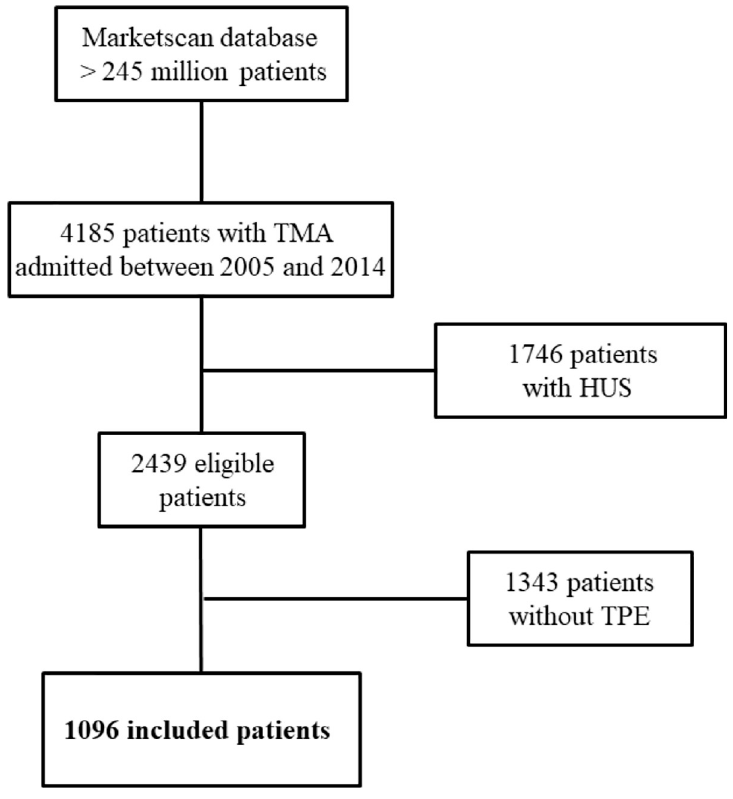
Fig 1. Study flowchart.